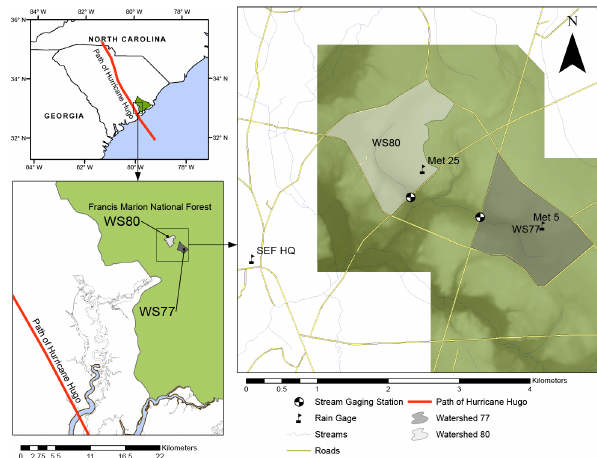
Fig. 1. Location of watersheds 77 and 80 in the Santee Experimen- tal Forest within the Francis Marion National Forest on the South Carolina coast in relation to the path of the eye of Hurricane Hugo, September